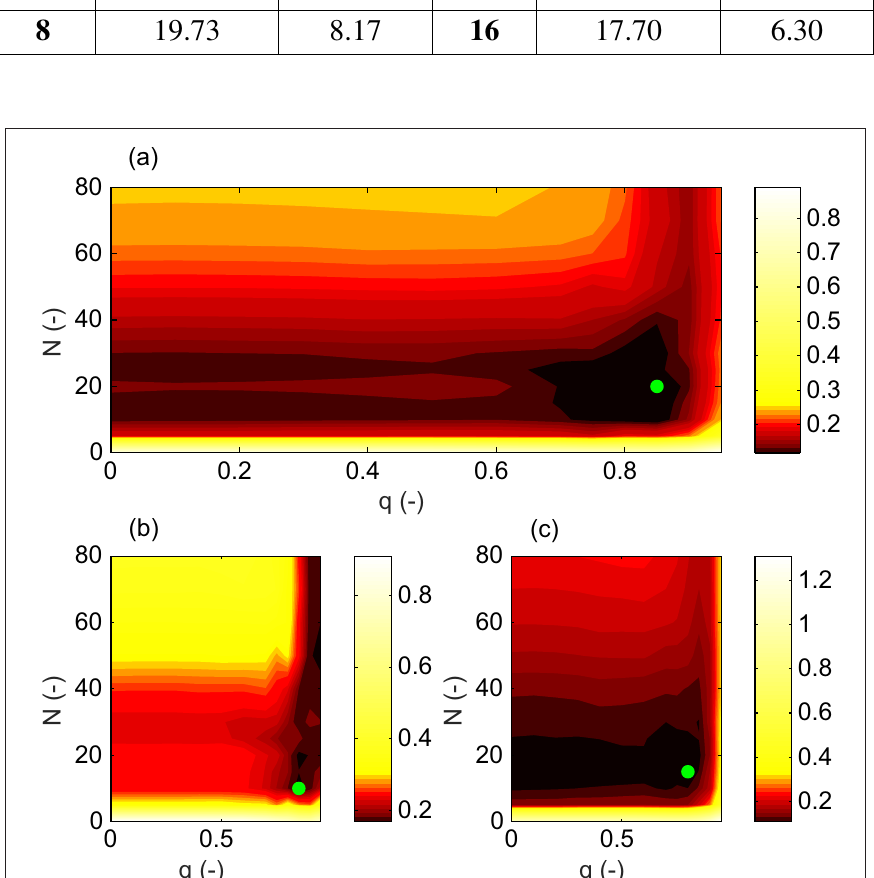
Figure 4. Pattern of the I index into the parameter space q-N ( a ) for all the selected events, 3 ( b ) for convective only, ( c ) and for stratiform only events. q = 0 implies the application of the methodology without any threshold. The green dots indicate the location of the